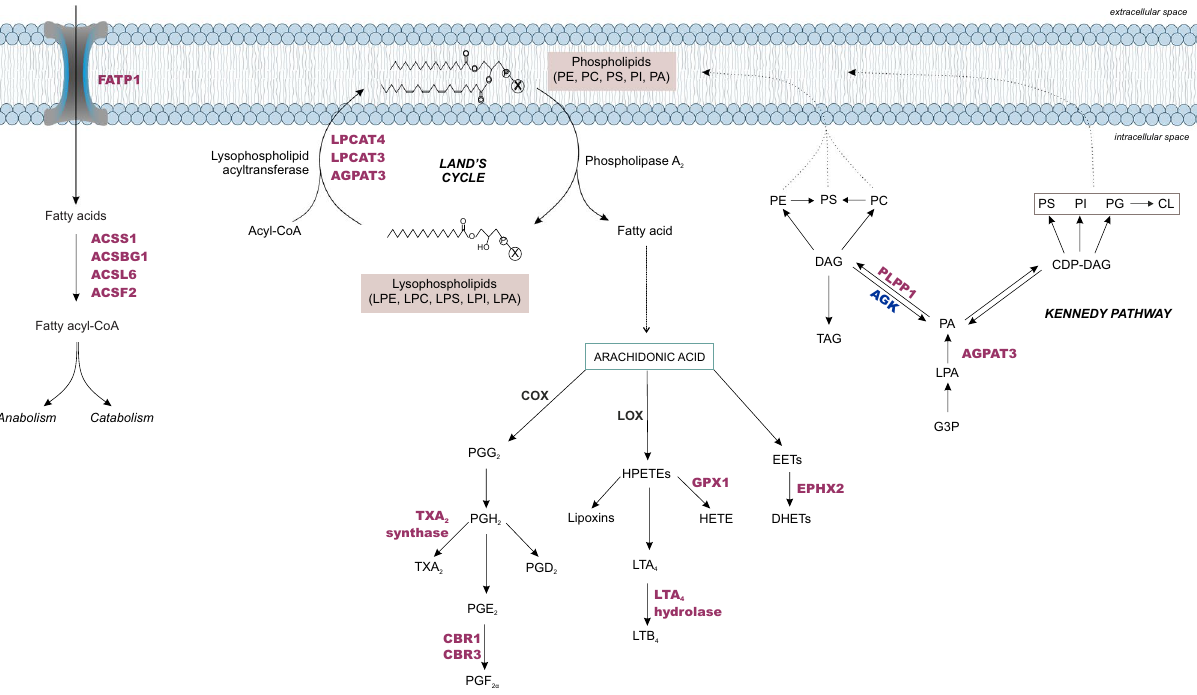
Figure 2. Biosynthetic pathways of glycerophospholipids in rat hippocampus. Glycerophospholipids are synthetized in the Kennedy pathway and subsequently remodeled in the Lands cycle, contributing to lipid diversity and the production of intracellular lipid mediators. The differentially expressed proteins revealed by proteomics in organotypic hippocampal slice culture are highlighted in pink (increased abundance in female) and blue (increased abundance in males). For more details, see Supplementary Dataset 1. Statistical analyses were performed by using Student’s t test followed by multiple testing corrections using the Benjamini–Hochberg procedure for false discovery rate (n = 5 biological replicates, each containing 3